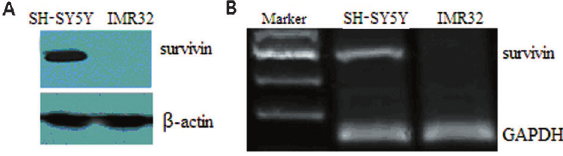
Figure 1. Expression of survivin in neuroblastoma cell lines. A , Representative Western blots to show the presence of survivin in neuroblastoma SH-SY5Y and IMR32 cell lines. Expression of b - actin was used as a loading control. B , Representative RT-PCR to show the expression of survivin mRNA. The expression of GAPDH mRNA was used as a loading